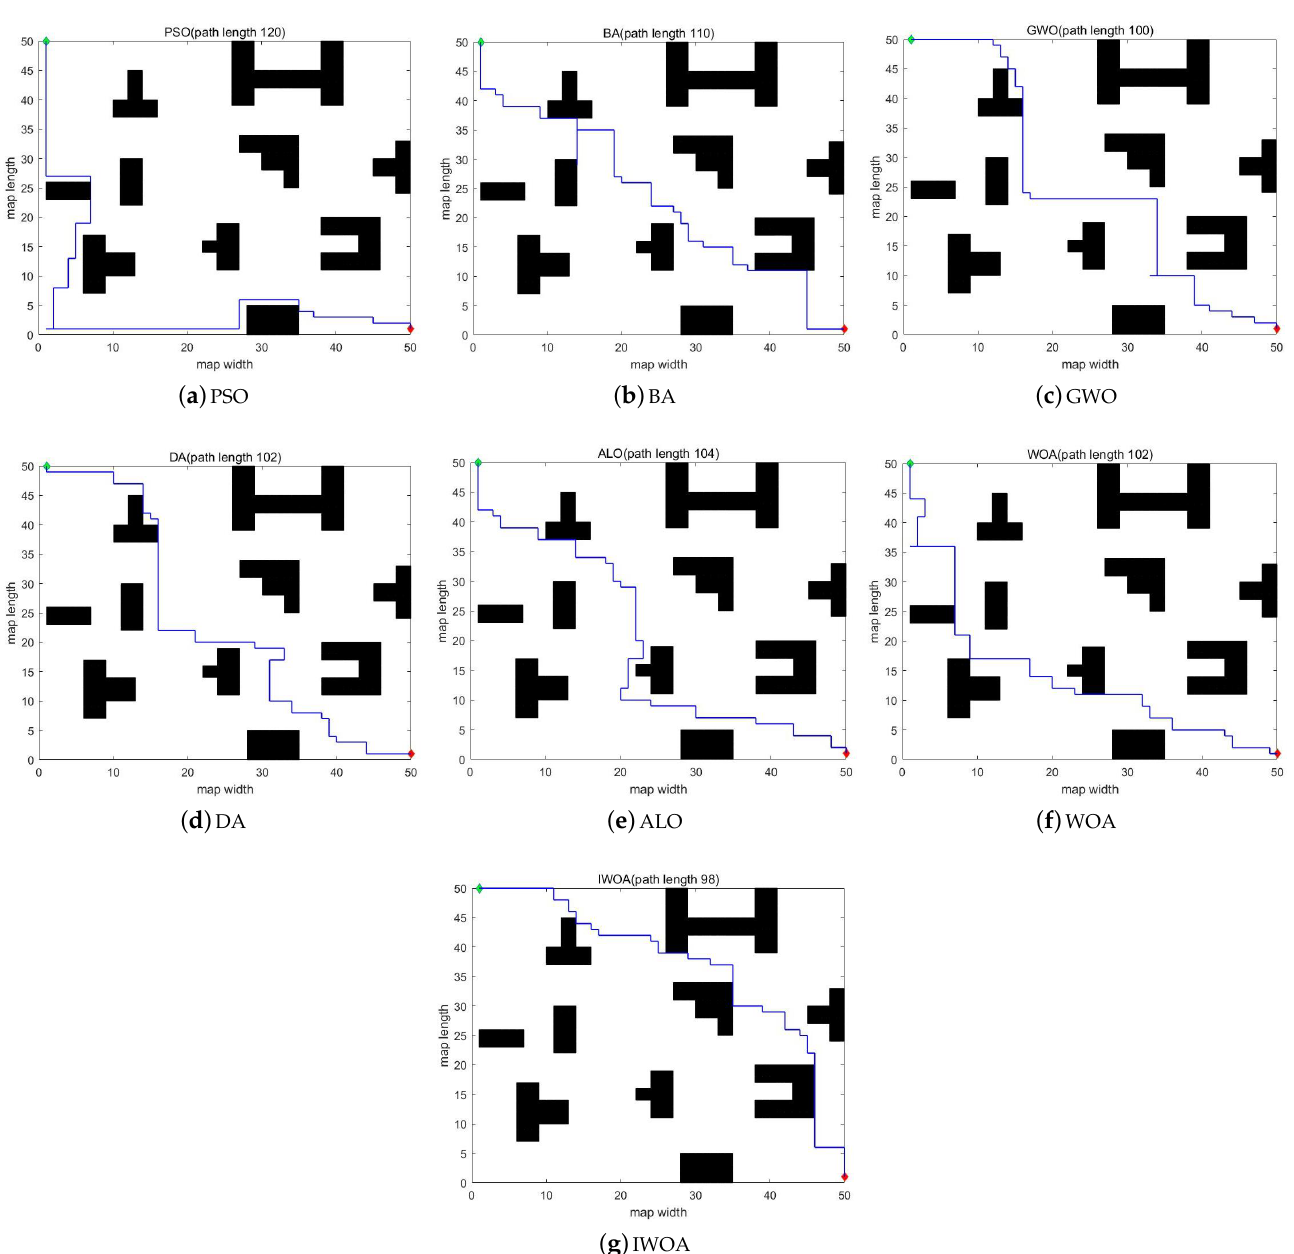
Figure 15. Actual path traces of seven different algorithms on 50 × 50 size